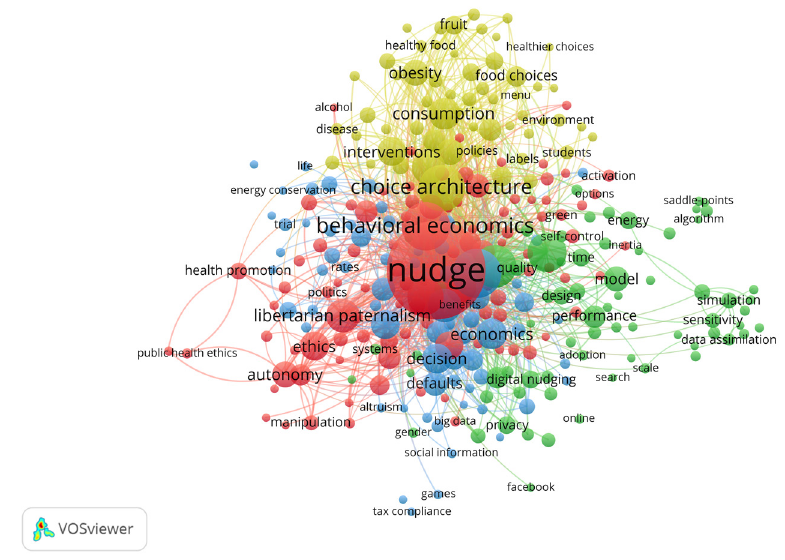
Figure 8. Network visualization of keyword co-occurrence